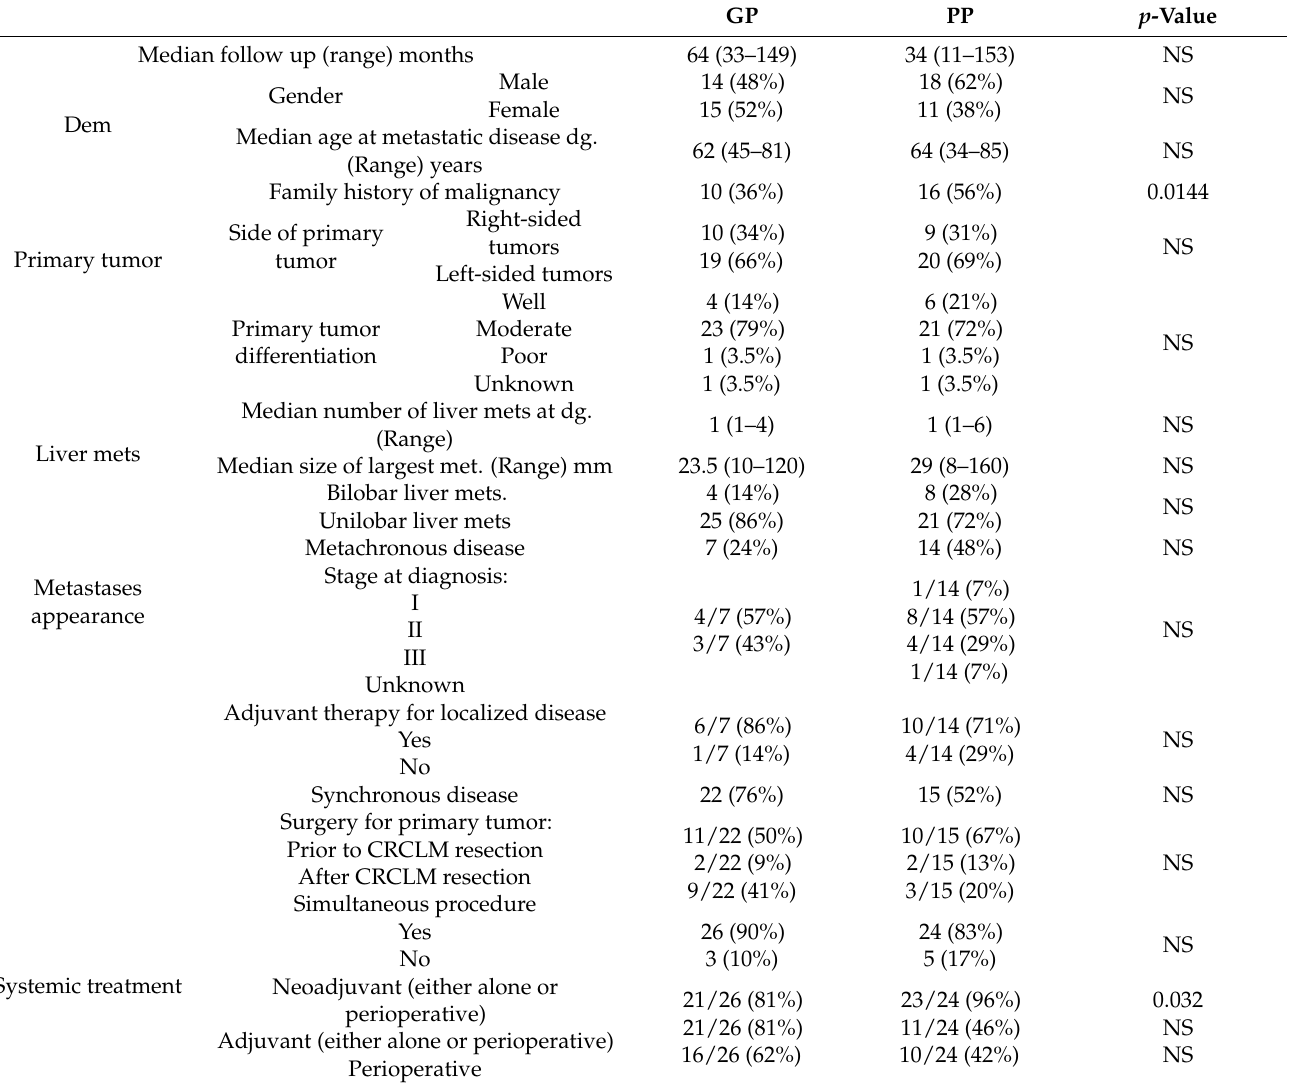
Table 1. Patients’